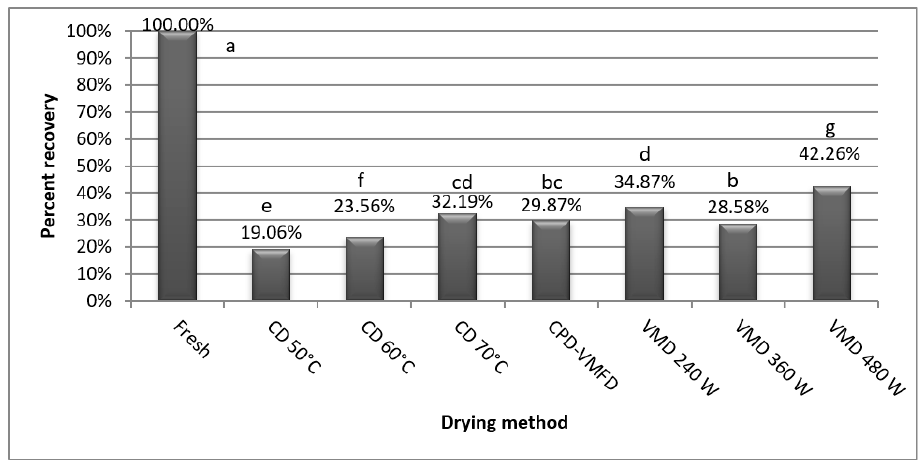
Figure 2. Percent recovery of essential oil of true lavender leaves after applying various drying methods.